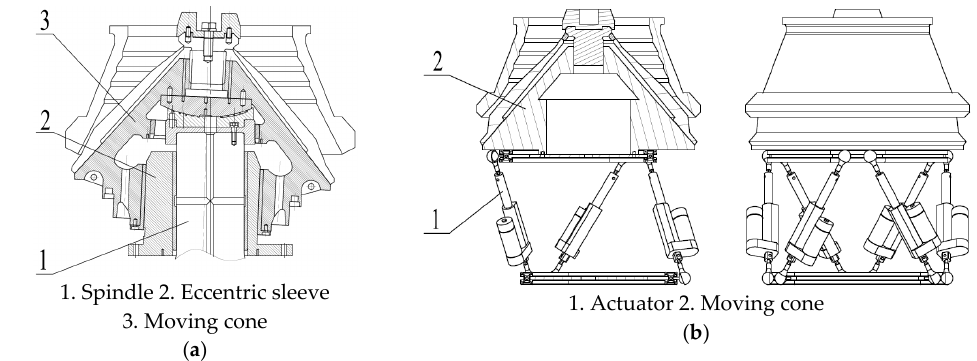
Figure 1. Relative compression ratio frequency of particles under different compression ratios: ( a ) Structure of the traditional cone crusher; ( b ) Structure of the intelligent cone crusher.